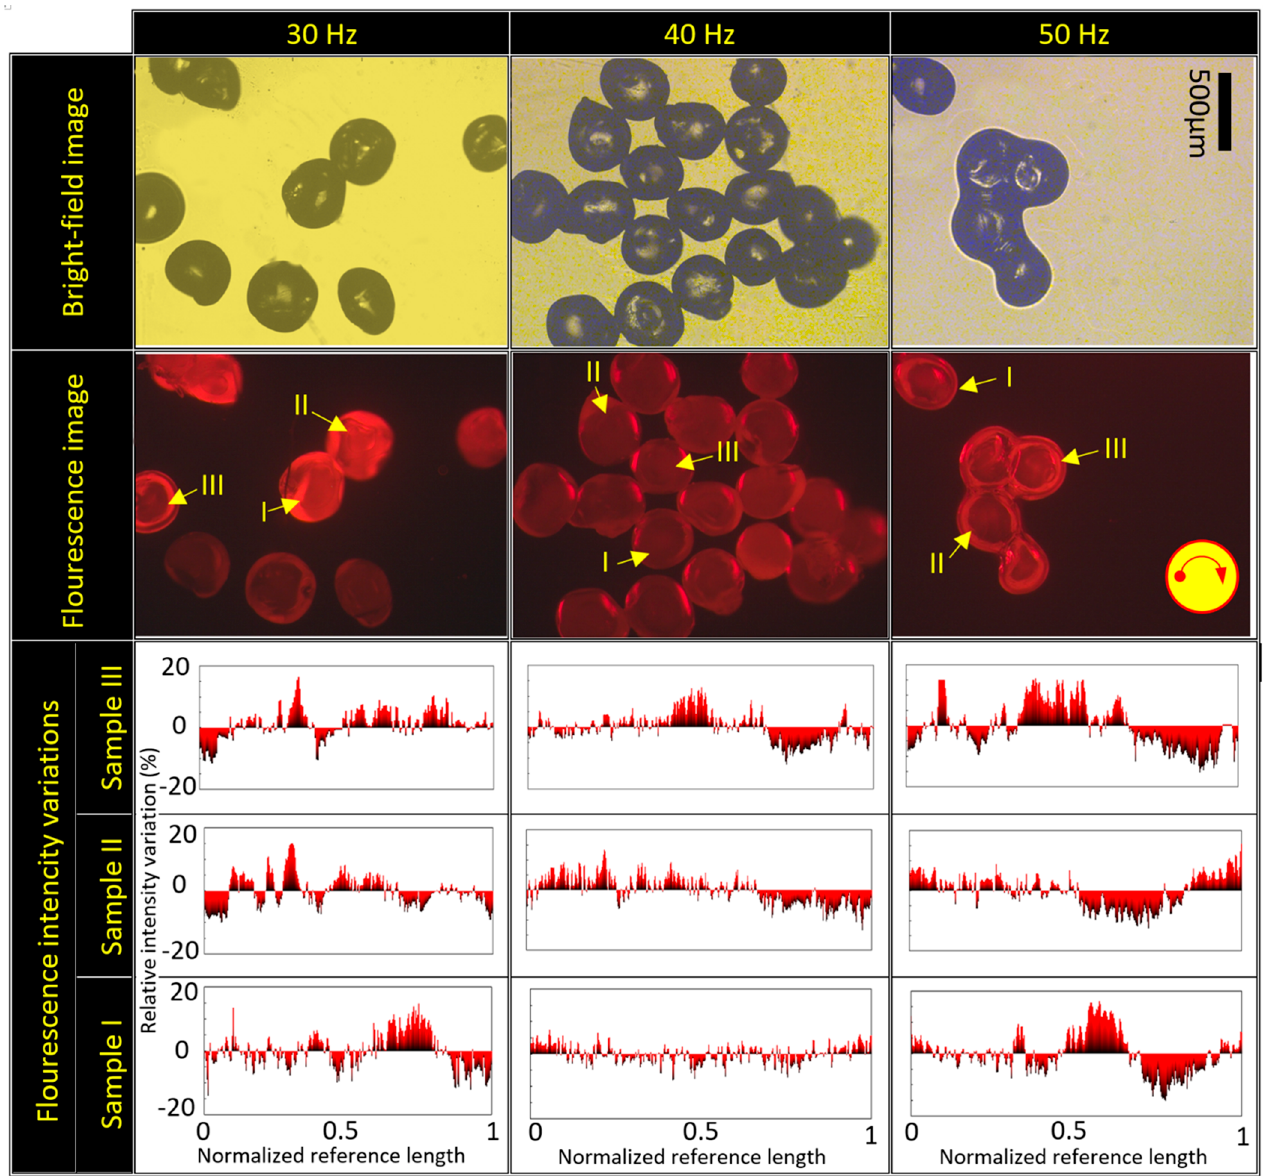
Figure 11. Fluorescence and bright-field images of the generated microparticles at 30, 40, and 50 Hz using the fluidic barrier length of 2 cm. Scale bar is 500 µm.